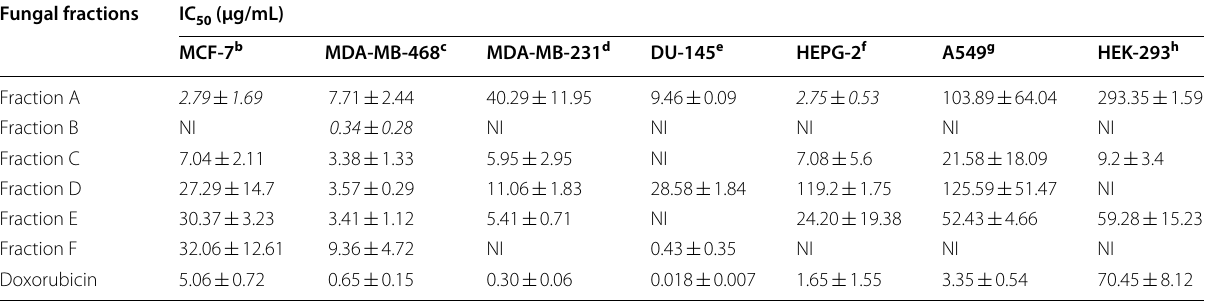
NI: no inhibition; Fraction A: toluene; B: chloroform; C: ethyl acetate; D: methanol, E: acetonitrile, F: water a 50% inhibitory concentrations and mean SEM of IC 50 (µg/mL) values of different fractions represent the mean of three individual experiments ± b Luminal-A (ER /PR /Her2 ) breast cancer + + − c Basal (low claudin) triple-negative (ER /PR /Her2 ) breast cancer − − − d Basal triple-negative (ER /PR /Her2 ) breast cancer − − − e Moderate metastatic potential (PSA ) androgen-independent prostate cancer + f Liver hepatocellular carcinoma g Adenocarcinoma human alveolar basal epithelial cells lung cancer